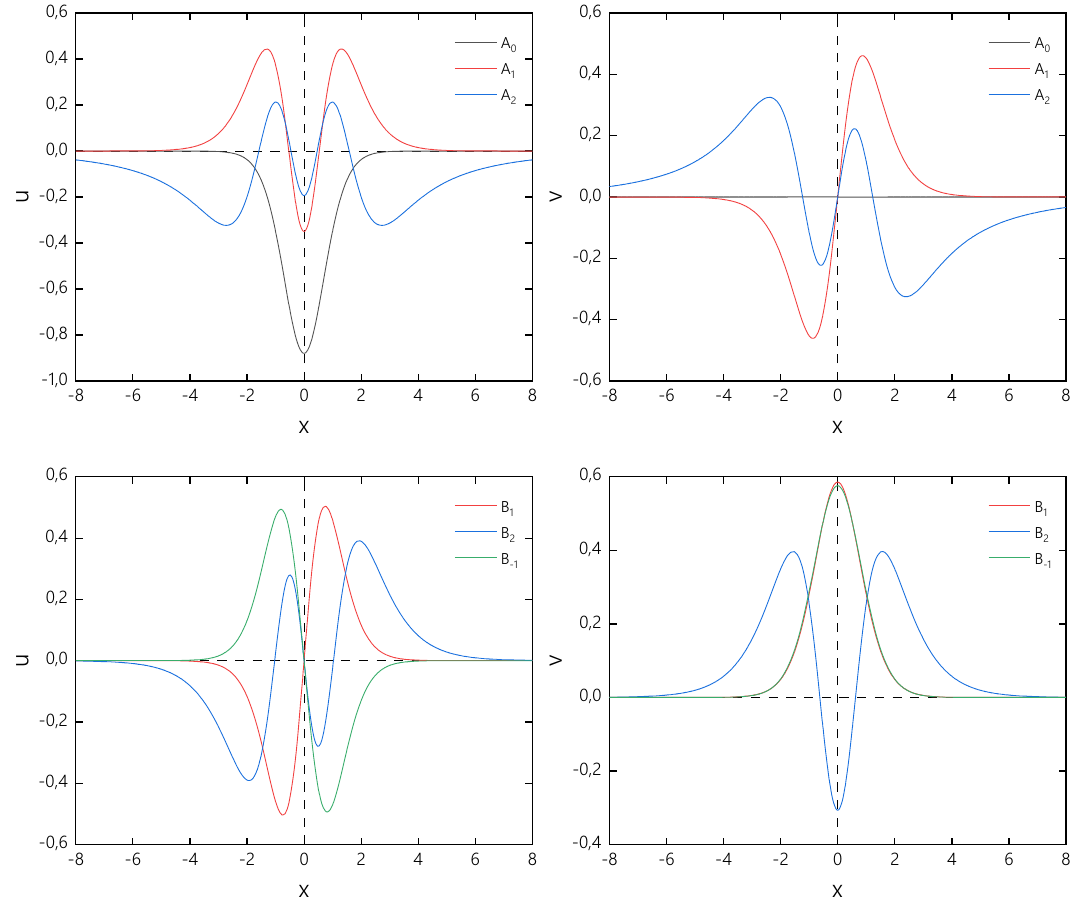
Fig. 1 Components of the localized fermionic modes of the types A n (upper row) and B n (bottom row) are plotted as functions of the coordinate x for m = 0 and g = 1